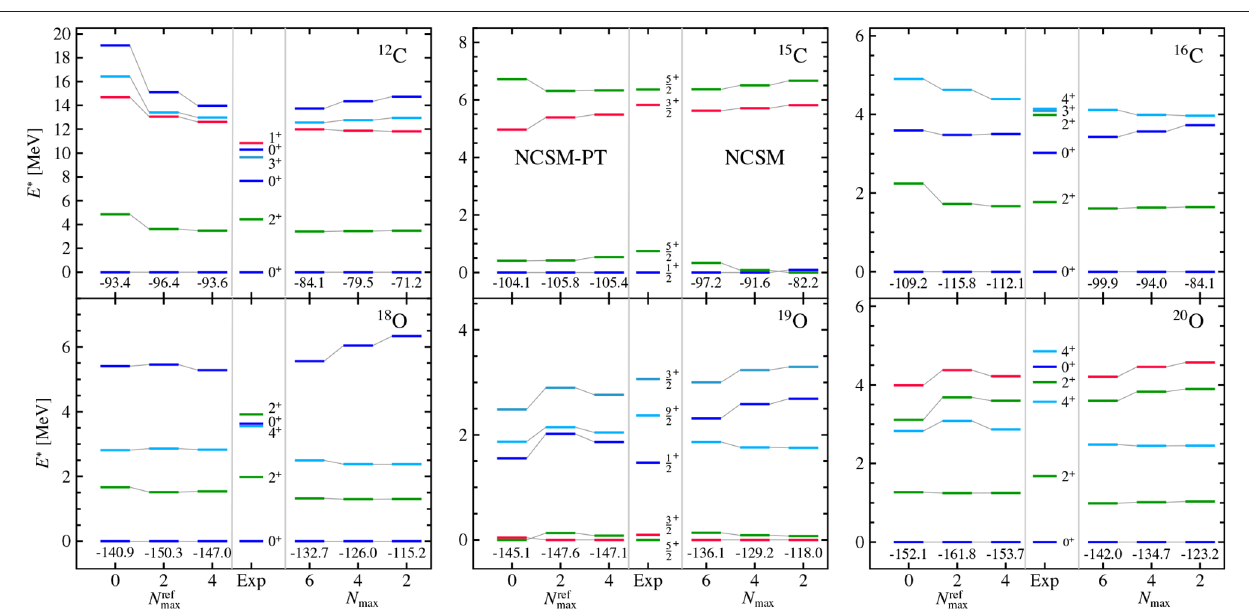
FIGURE 8 | Spectra obtained via second-order NCSM-PT for selected carbon and oxygen isotopes using the Hamiltonian described in section 3. All calculations are performed using 13 oscillator shells and an oscillator frequency of ¯ h ω = 20MeV. The SRG parameter is set to α = 0.08fm 4 . A HO single-particle basis was used to separate center-of-mass contaminations. Large-scale IT-NCSM calculations are shown for comparison. Reproduced from Tichai et al. [ 36] under the Creative Commons CC-BY